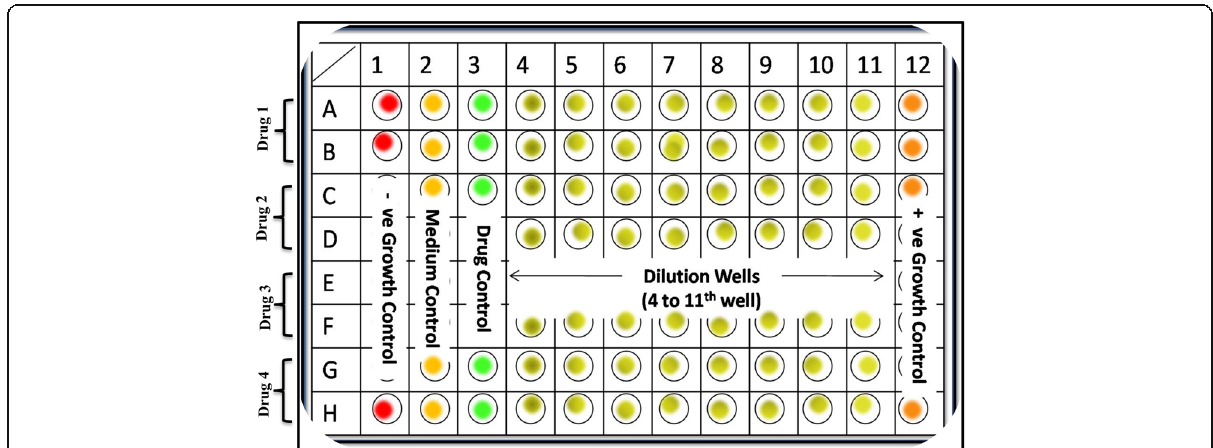
Fig. 2 Pictorial representation of CLSI recommended broth micro-dilution protocol. a – h contains drugs (50mg/ml) in duplicated: a , b contains